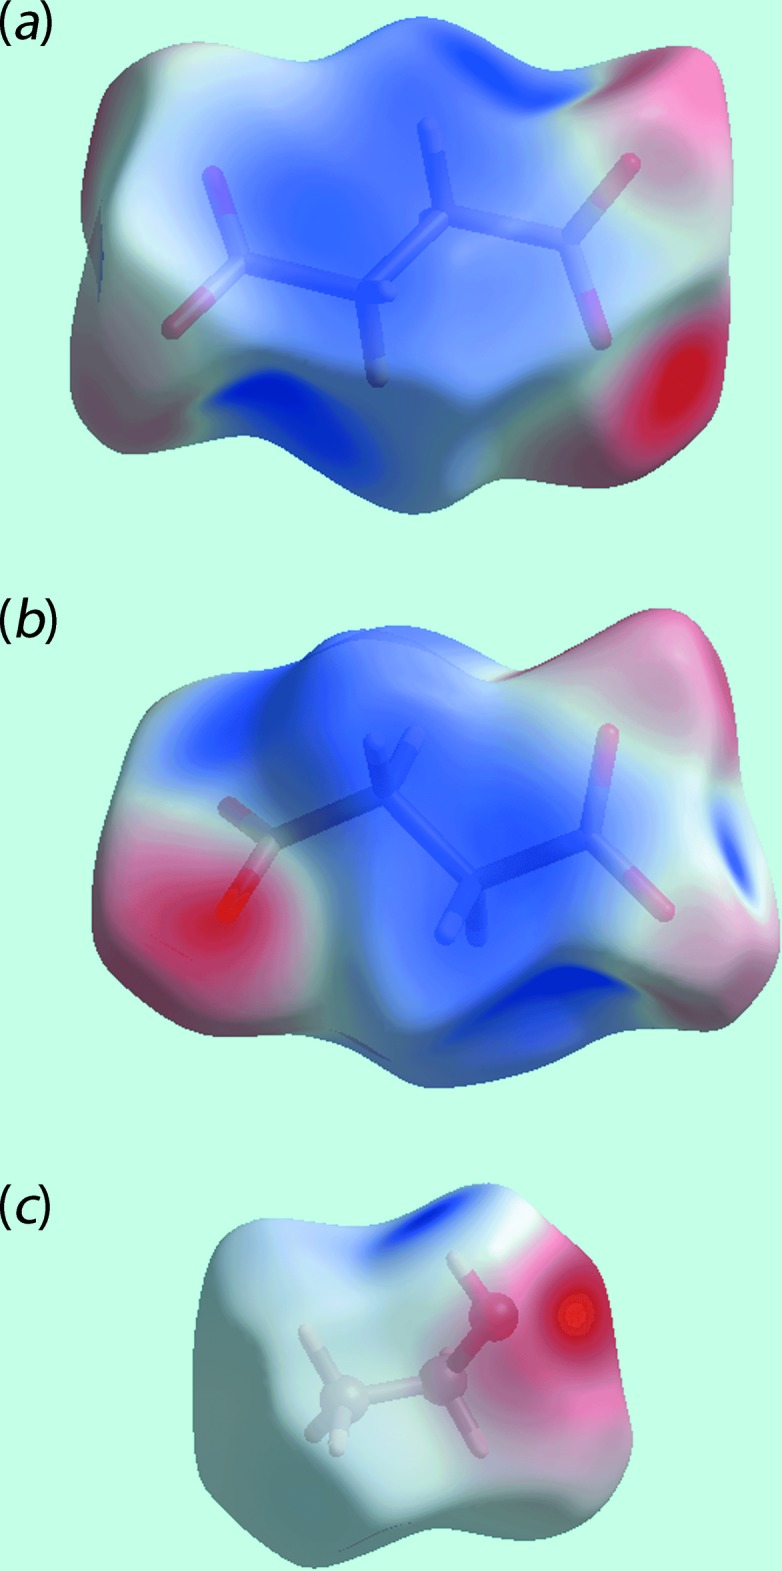
Views of Hirshfeld surface mapped over electrostatic potential for the: (a) and (b) dianion in the range −0.072 to +0.066 atomic units (au) and (c) ethanol mol­ecule (−0.077 to +0.159 au). The red and blue regions represent negative and positive electrostatic potentials, respectively.